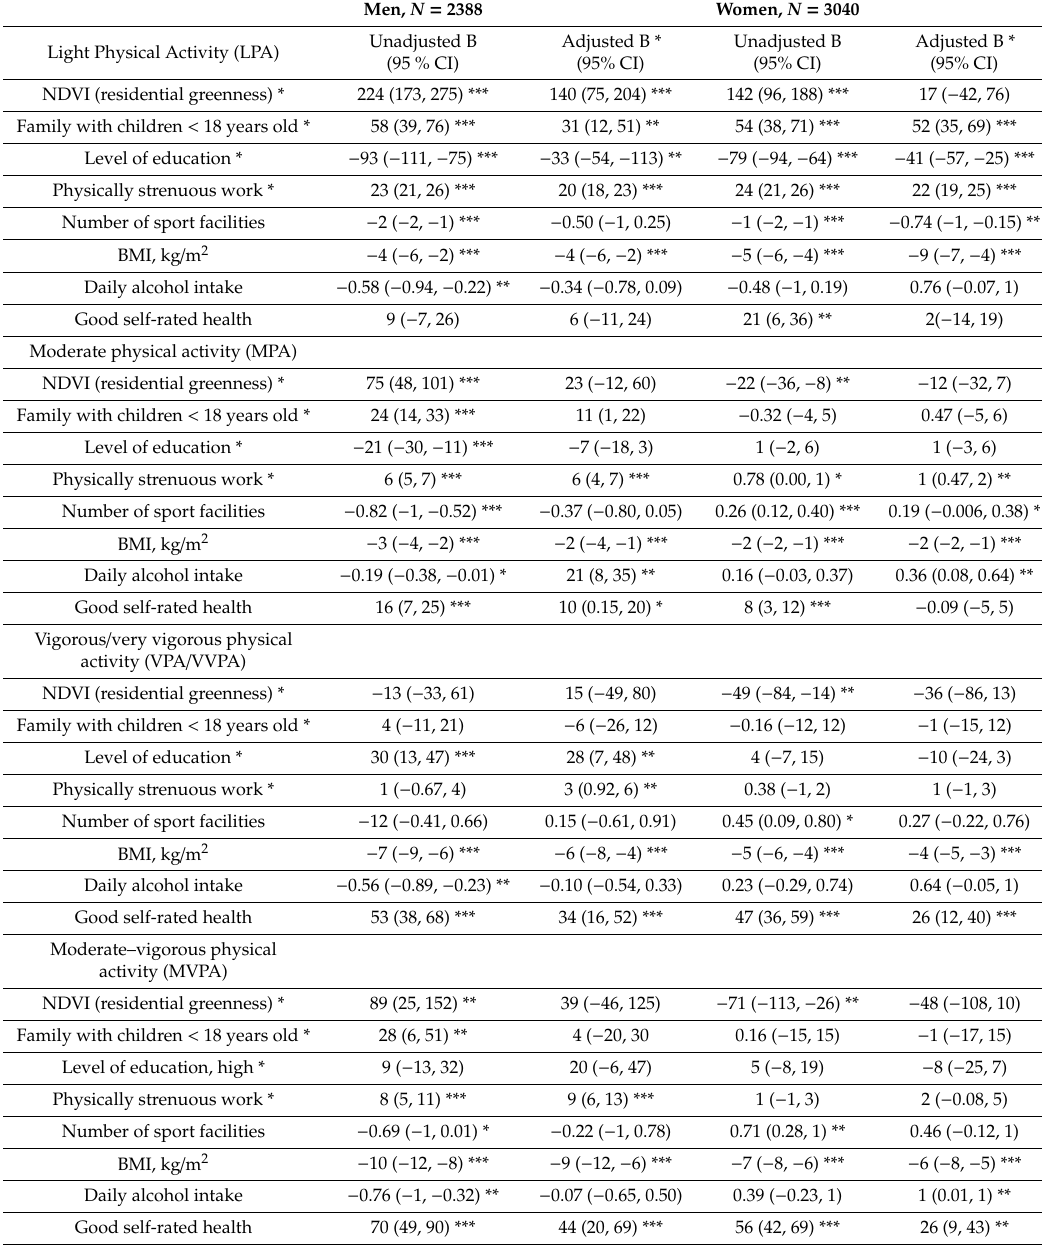
Table A2. Factors associated with accelerometry measured LPA, MPA, VPA / VVPA, and MVPA (daily average MET-minutes) among men and women separately according to multivariable linear regression. Men, N = 2388 Women, N = 3040 Unadjusted B Adjusted B * Unadjusted B Light Physical Activity (LPA) (95 % CI) (95% CI) (95%